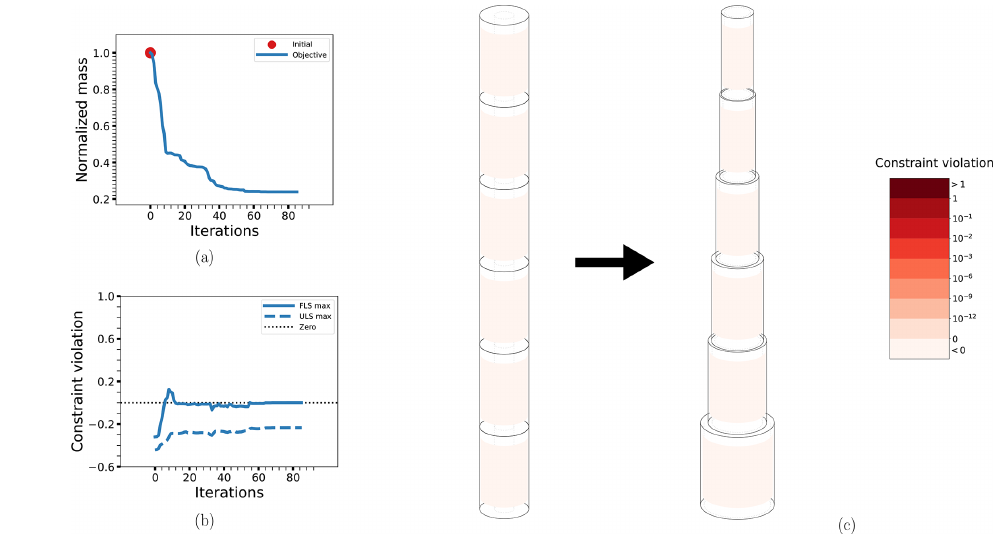
Figure 9. The optimization process for case BEAM-DA: the objective function (a) , maximum non-linear constraint violations (b) and the change in the design from initial to final configuration (c) . Details as in previous